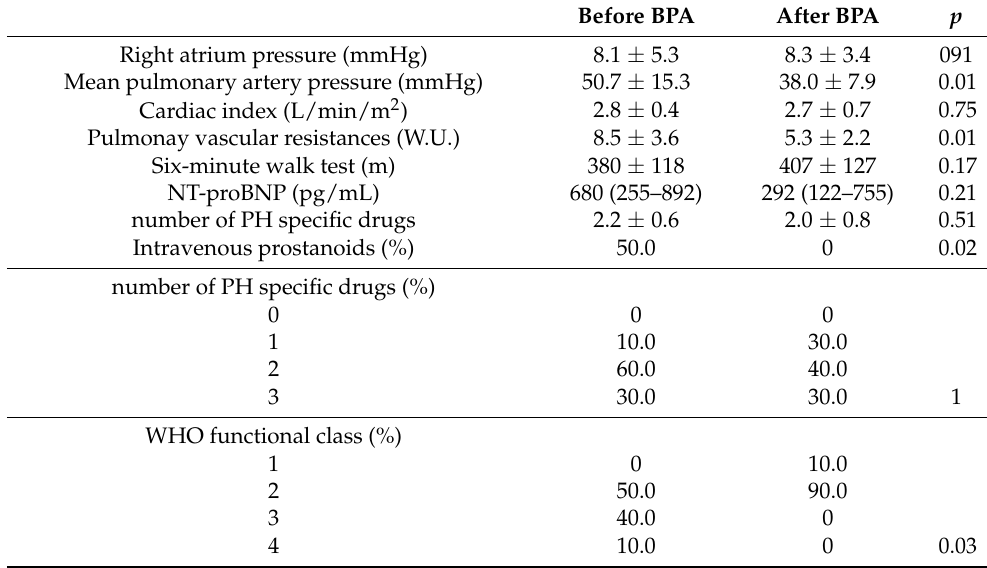
Table 3. Response variables pre and postBPA in postsurgical patients ( n =